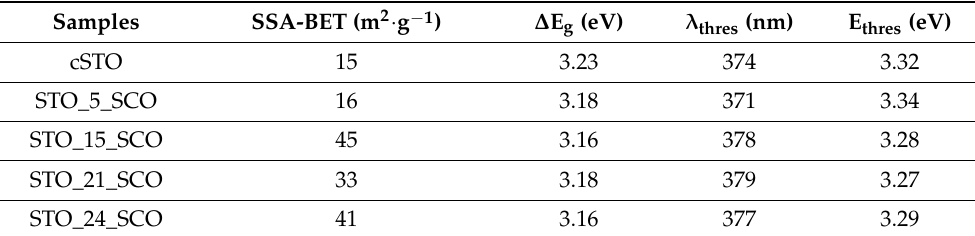
Table 2. Specific surface area and optical properties of the studied catalysts. Samples